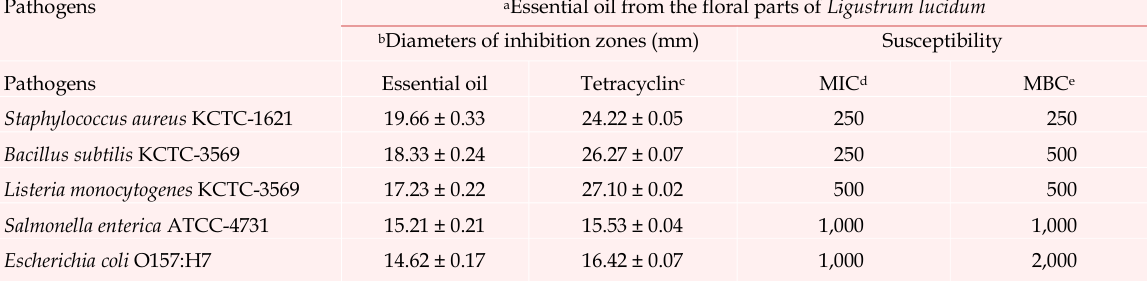
Antibacterial potential essential oil of isolated from the floral parts of L. lucidum against pathogenic bacteria